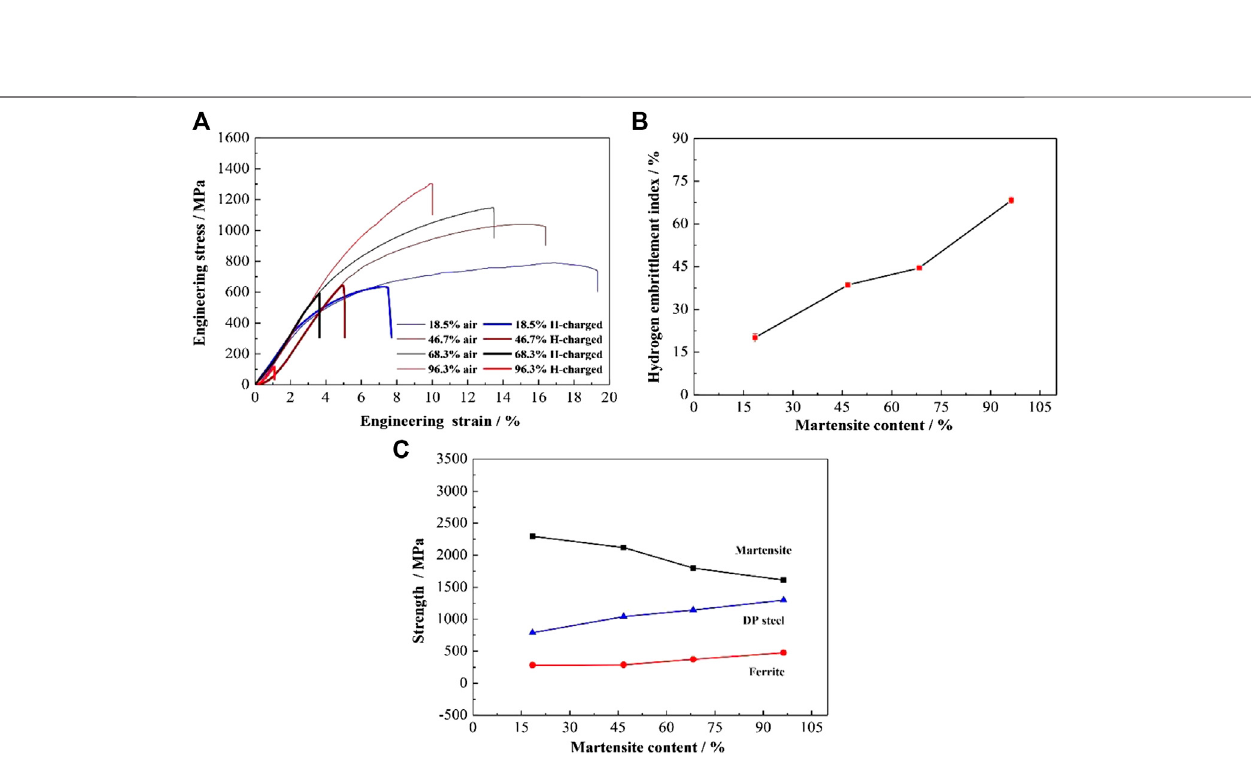
Frontiers in Materials |